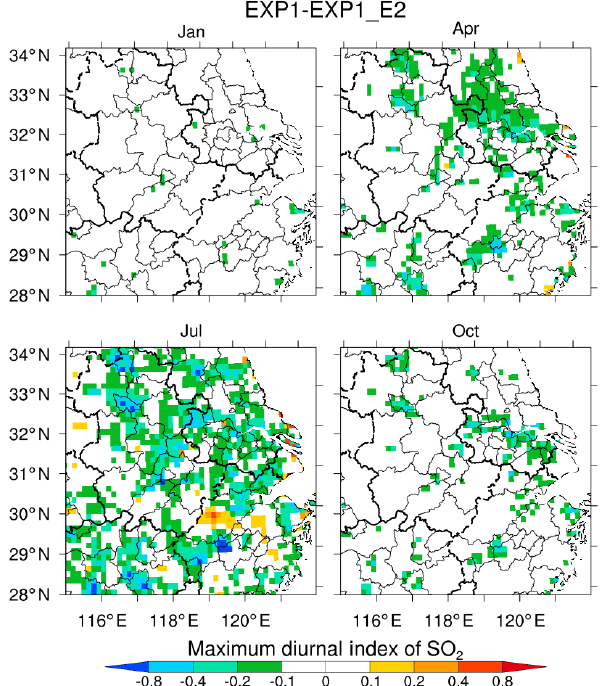
Figure 16. Spatial distribution of the difference in the daily maxi- mum diurnal index of surface SO 2 concentrations between experi- ments EXP1_E2 and EXP1 over East China in January, April, July, and October of